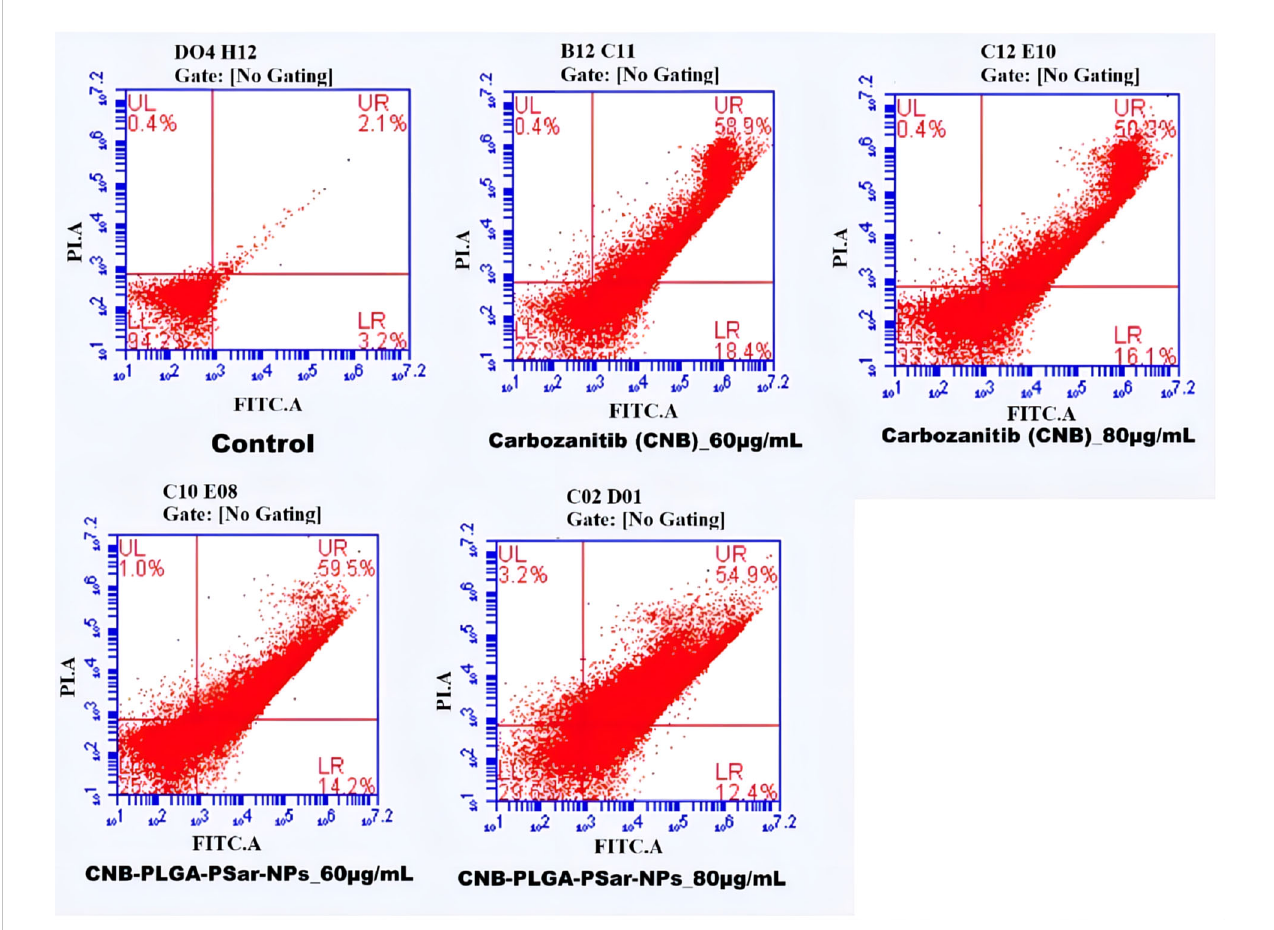
FIGURE 6 Flow cytometry analysis of HepG2 cells treated with different concentrations of CNB loaded CNB-PLGA-PSar-NPs and free CNB for 48 h, followed by staining with Annexin V-FITC and propidium iodide (PI). Results are representative of three independent